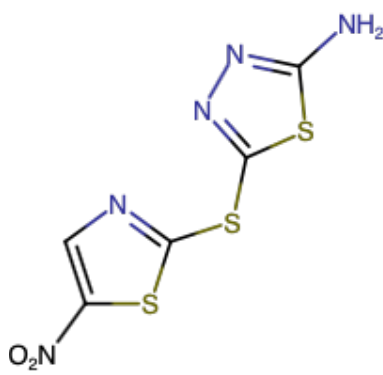
Figure 2. The chemical structure of halicin, which was drawn by chem-space.com.